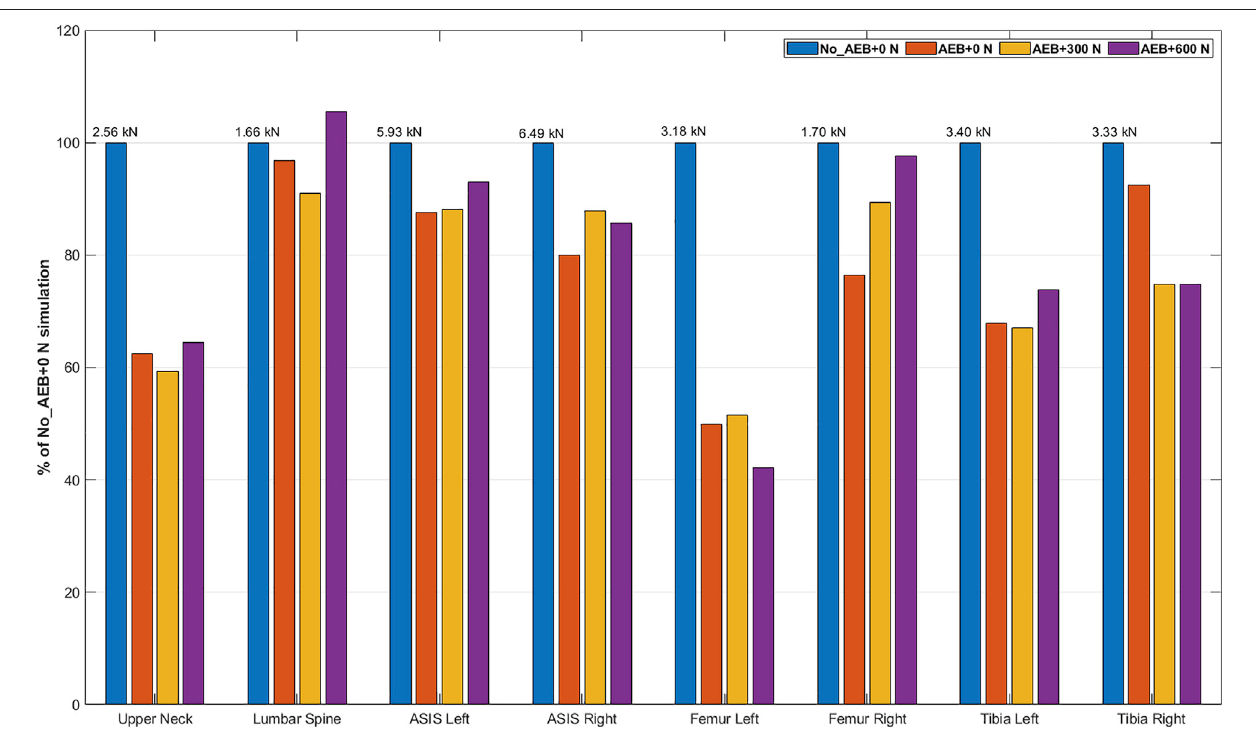
FIGURE 5 | Comparison of the upper neck tension forces, lumbar spine compression forces, and ASIS, femur, and tibia resultant forces across the four simulations. The values on the top of each blue bar represent the peak forces of each body region in the No_AEB+0N simulation which were normalized to 100%.